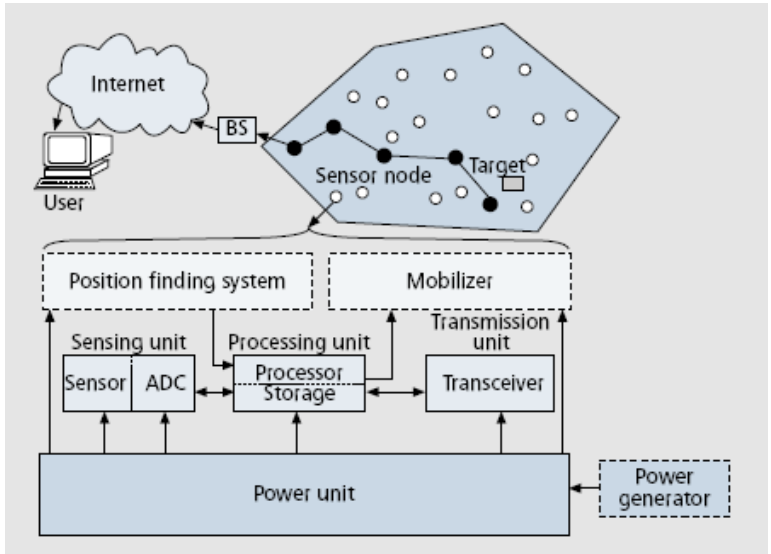
Figure 1. The simple description of WSN [4].